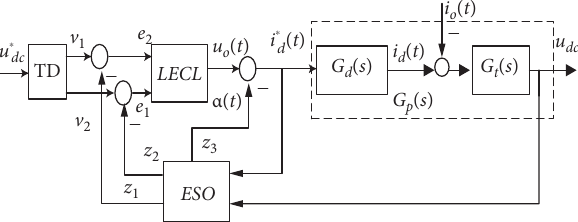
Figure 3: Block diagram of double closed-loop control